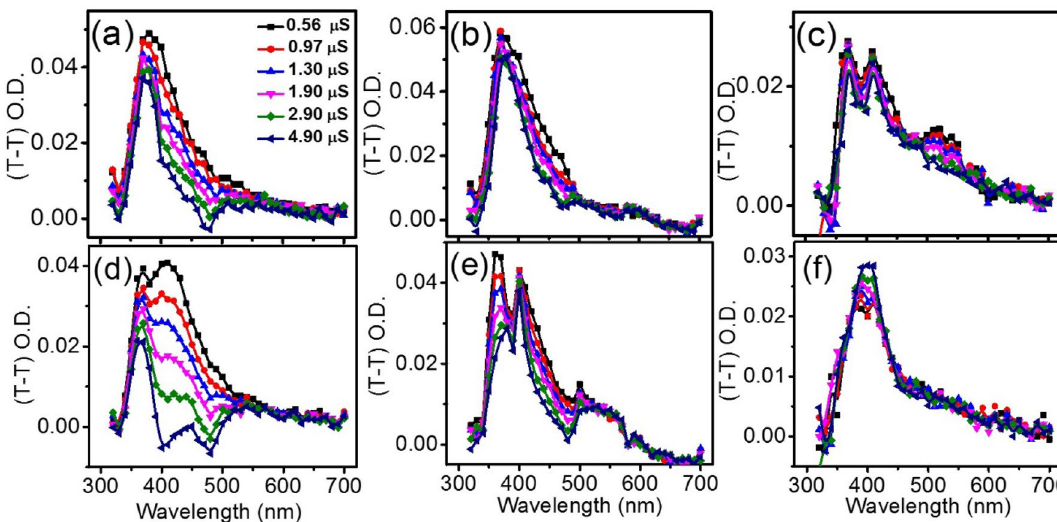
Figure 4. Transient absorption spectra of ( a ) MQ-ADN, ( b ) Au MQ-ADN and, ( c ) Fe MQ-ADN respectively generated between the pump and probe pulse delay from 0.5 to 4.9 μs time delay after the laser flash in the absence of MF and their respective spectrum in the presence of MF is shown in ( d )–( f ).